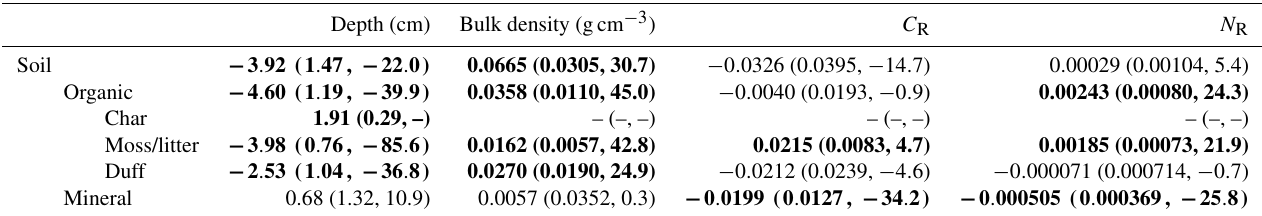
Table 4. Mean values of distributions ( n = 50) formed by subtracting control plot variables from their paired burnt plot. In parentheses are first the 95% confidence interval of the distribution and then the percentage change calculated from the overall means of control and burnt plots. Statistically significant fire-induced changes are in bold.